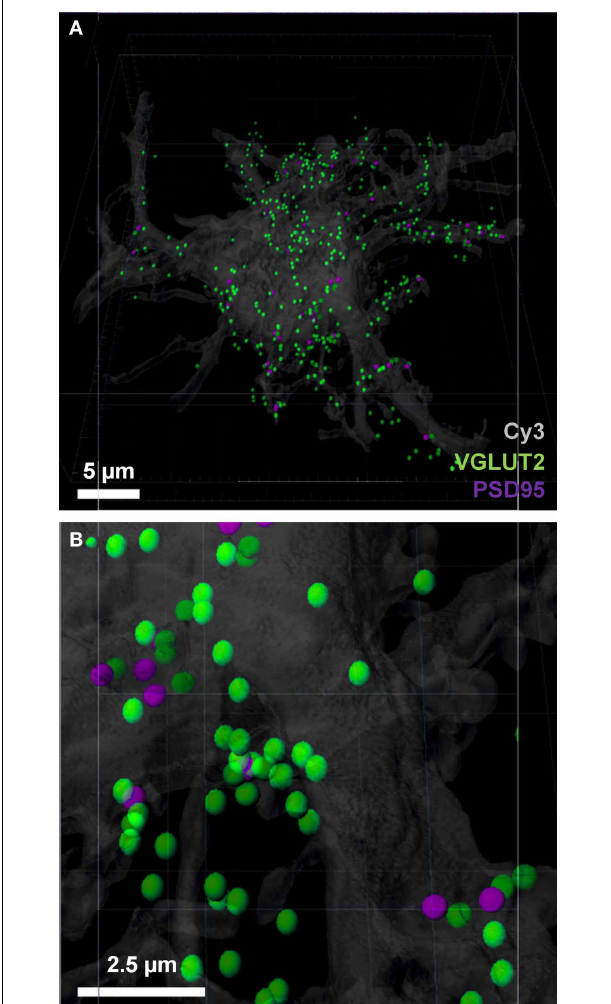
FIGURE 4 | Pre-synaptic and post-synaptic localizations to the filled motor neuron. (A,B) show the pre-synaptic VGLUT2 (green) localized to within 1 μ m of the neuronal surface and post-synaptic PSD-95 (purple) Imaris-generated “spots” with the neuronal surface. Evident is the increased amount of VGLUT2 puncta quantified using the neuron as the localization point, as opposed to the post-synaptic specialization used in Figure 3 . Scale bars: (A) 5 μ m and (B) 2.5 μ m.